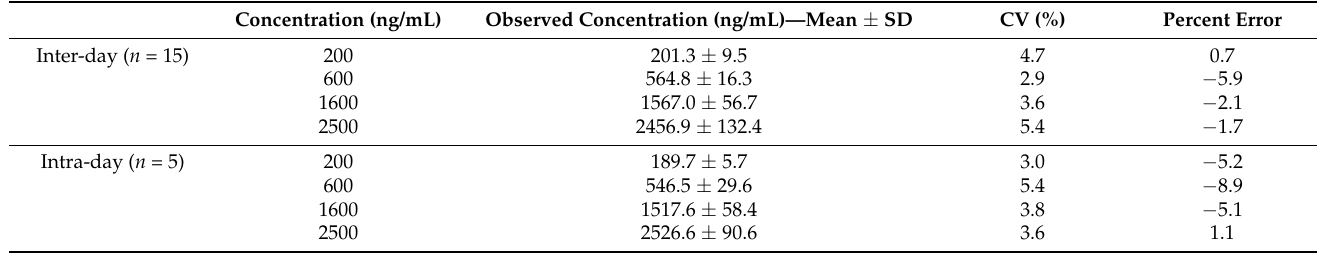
Table 2. Inter- and intra-day accuracy (%error) and precision (%CV) for N -desmethylclobazam (NDMCLB). Concentration (ng/mL)